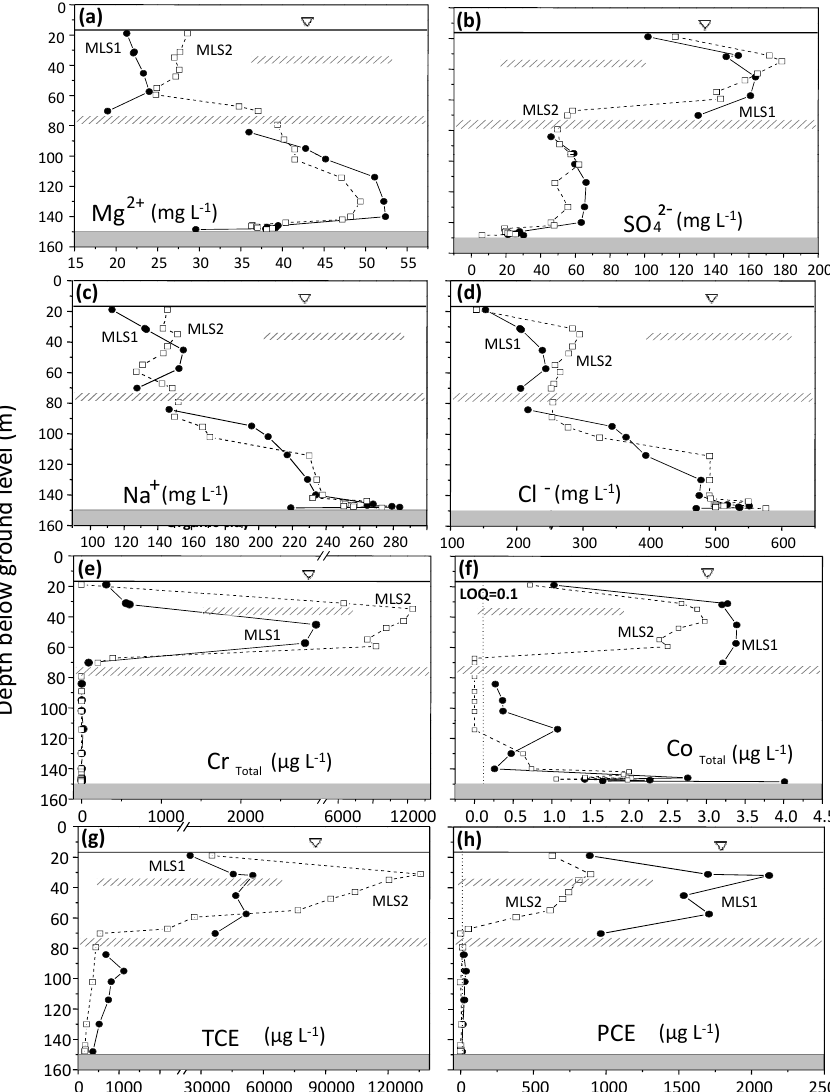
Fig. 4. Representative deep aquifer profiles obtained in sequential sampling campaigns. (a – d) major ions; ( e , f ) trace elements and ( g, h ) volatile organic compounds (VOCs). MLS1 (circles) obtained 10 August 2008; MLS2 (squares) obtained 1 June 2009. Saqiye Group clay in gray is the bottom aquifer boundary and clayey layers around 35 and 75m depth are illustrated with dashed lines (Fig. 2). LOQ (f) – limit of